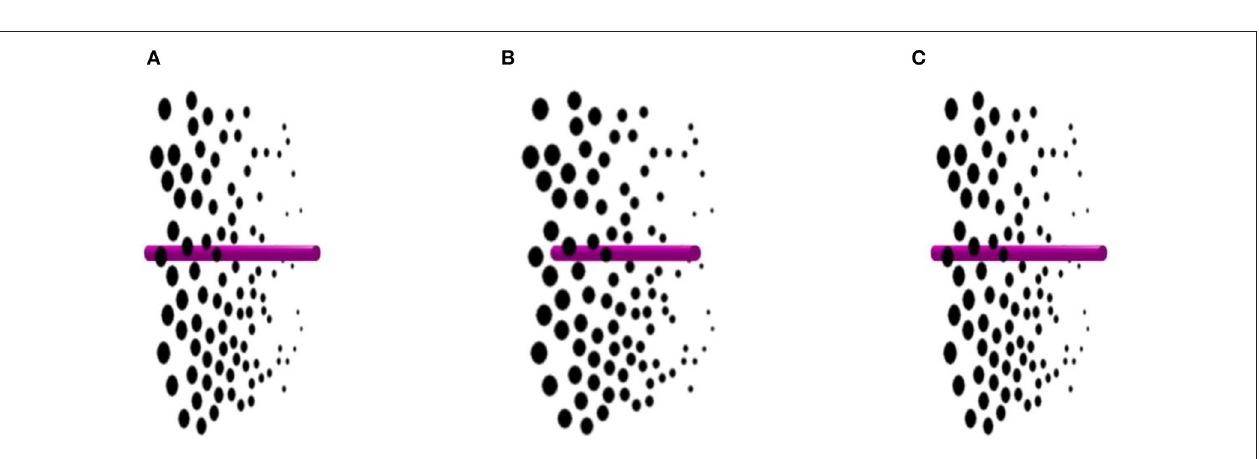
FIGURE 2 | A new size gradient illusion. A stereoscopic layer of black disks appears to oscillate back and forth over a 180 ◦ range around the vertical axis, although it physically rotates 360 ◦ continuously. Size of the disks varies across the virtual glass plane. Panels (A) and (C) are identical, while panel (B) contains disparity. Please see Supplementary Video 2 for an animation.